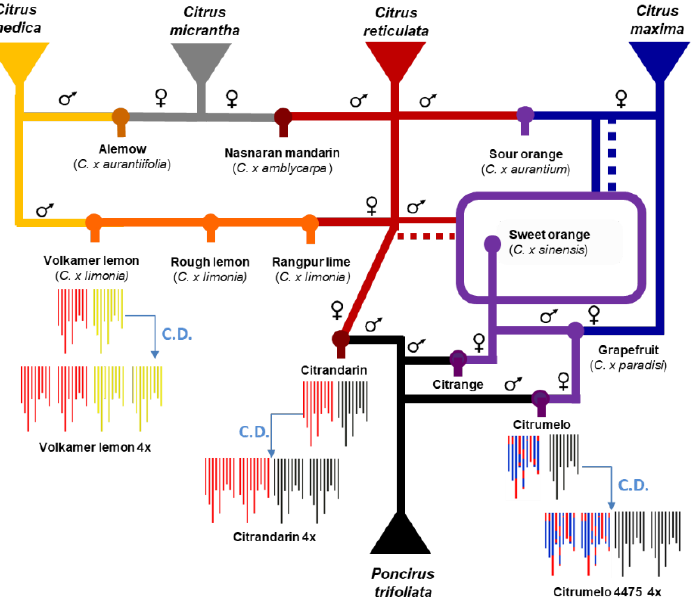
Figure 1. Phylogenetic origin of important interspecific citrus rootstocks and phylogenomic structure of the three tetraploid parents used in this paper. CD: Chromosome doubling of nucellar cells. Ancestral genome contribution: Yellow: C. medica ; grey: C. micrantha ; Red: C. reticulata ; Blue: C. maxima; Black: P. trifoliata.